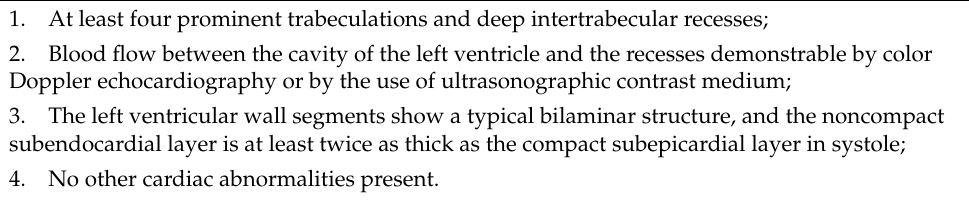
Table 4. Echocardiographic criteria for the diagnosis of NCCM in the German NCCM registry